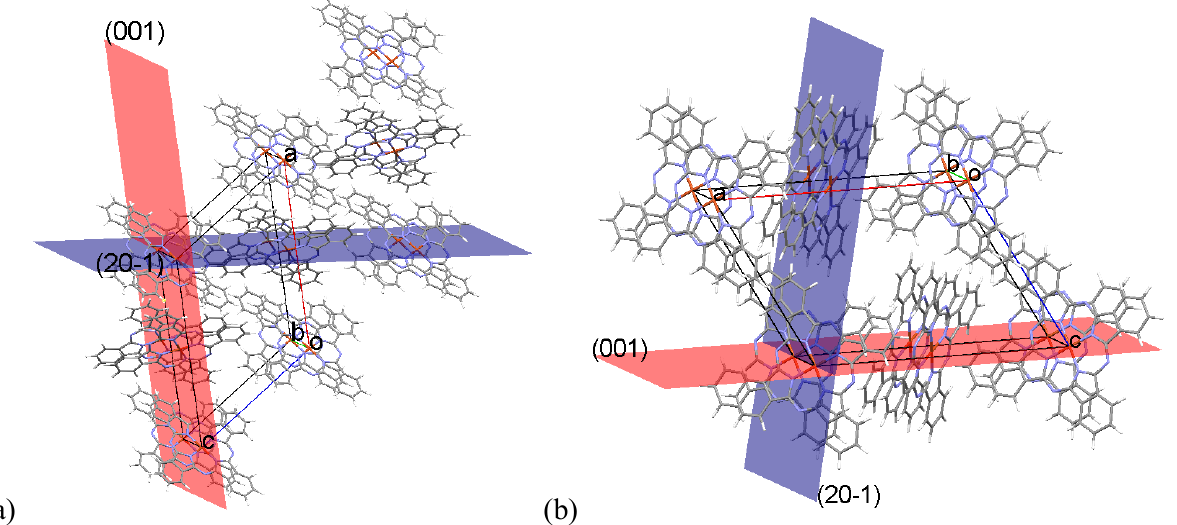
Figure 4. (a) The primary arrangement of CuPc crystallite in the (20 ) orientation. (b) The secondary arrangement of CuPc crystallite in the (001) orientation (CuPc single crystal diffraction information was found in database, and then was input into Mercury 2.4 software [20] to display).